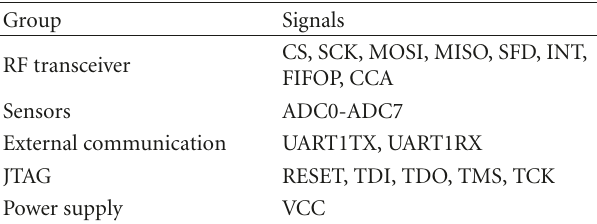
Table 2: List of Signals to capture in